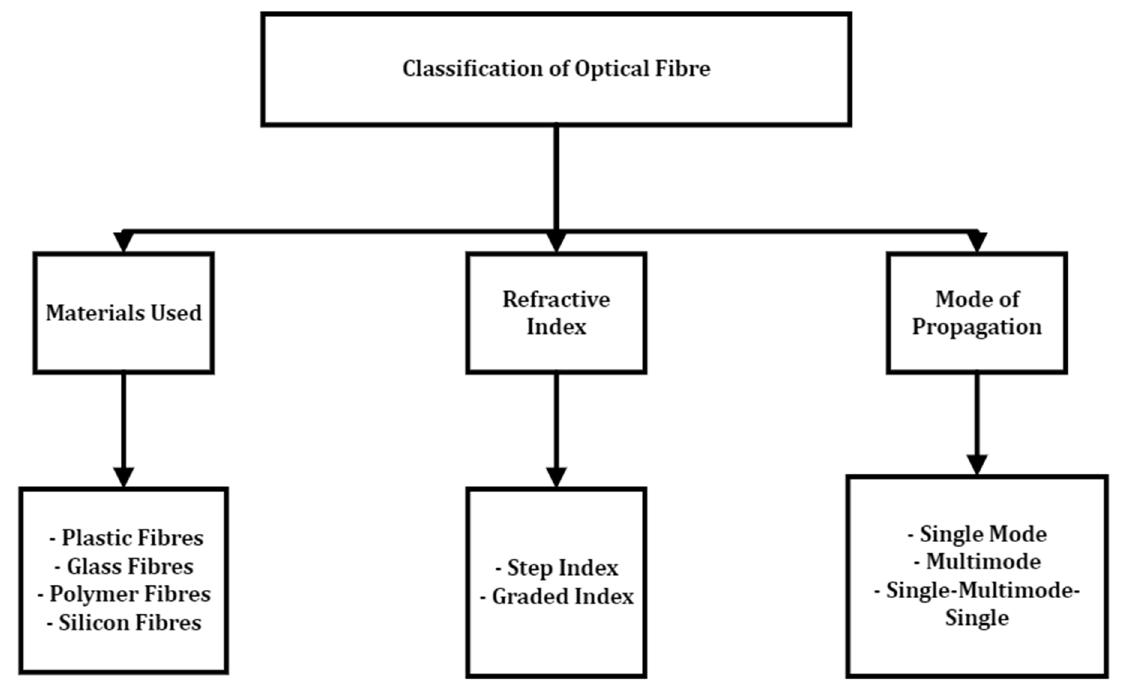
Figure 9. Optical fibre classification.